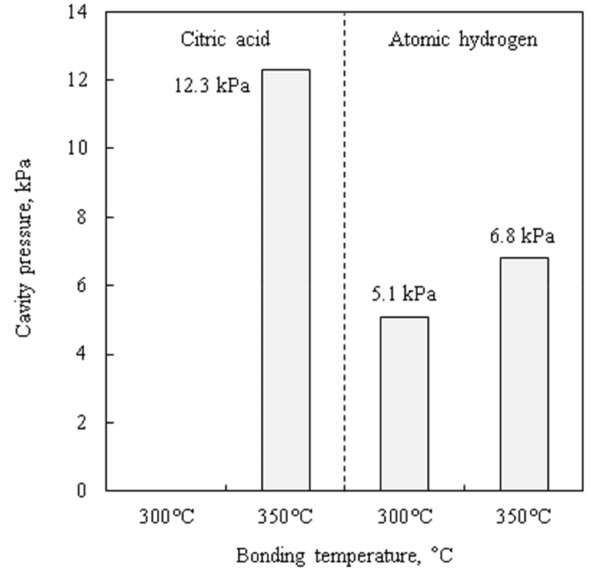
Figure 7. Hermetic sealed cavities pressure measured by zero-balance